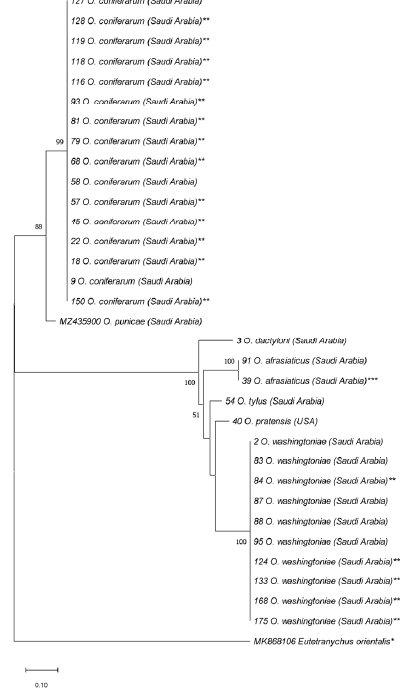
Figure 3. NJ phylogenetic tree based on 33 ITS2 sequences, representing different samples of seven Oligonychus species. Eutetranychus orientalis * was retrieved from GenBank and used as an outgroup taxon. A total of 30 sequences were obtained in the present study from different hosts and regions in Saudi Arabia and one from USA (** including 19 samples that have not been identified morpho- logically till species due to the absence of males, and *** one sample that was previously claimed as O. pratensis from Saudi Arabia) [23]. One sequence of O. punicae was retrieved from GenBank, pre- viously reported from Saudi Arabia [7]. Numbers on tree branches are bootstrap values obtained from 1000 replicates.